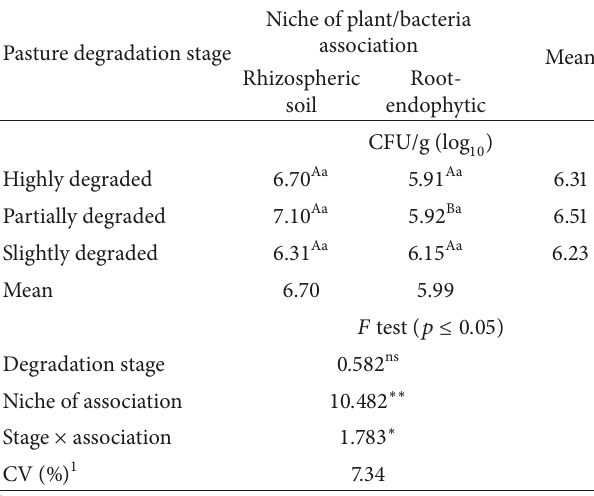
Table 2: Population density of the cultivated diazotrophic bacterial community in different niches of plant/bacteria association in B. decumbens Stapf . pasture in different degradation